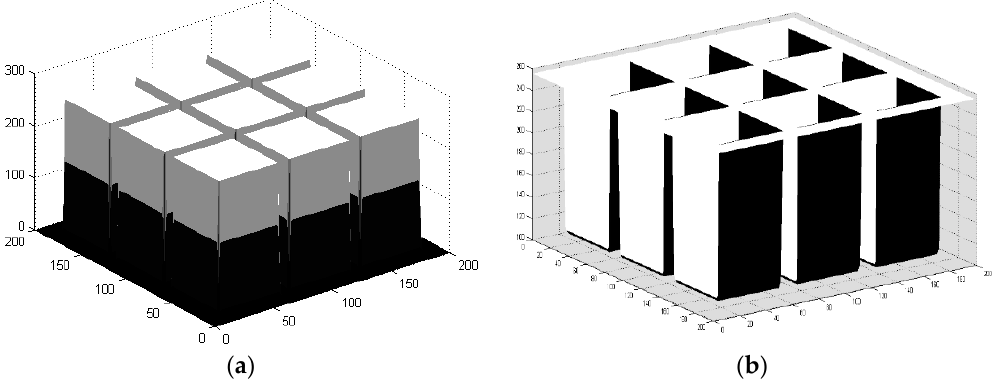
= 0, v o = 150; ( b ) v = 255, v o = b b